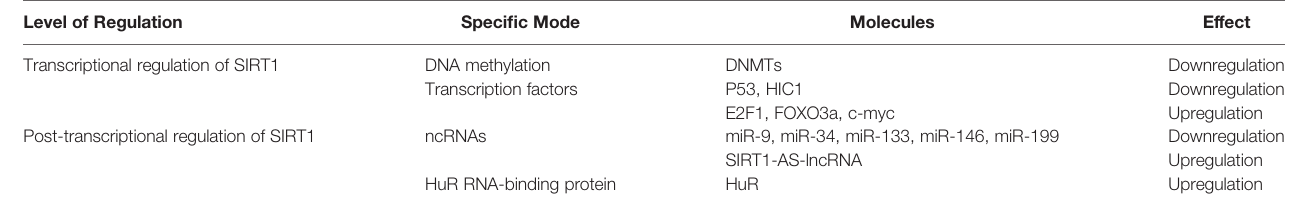
TABLE 1 | Regulation of SIRT1